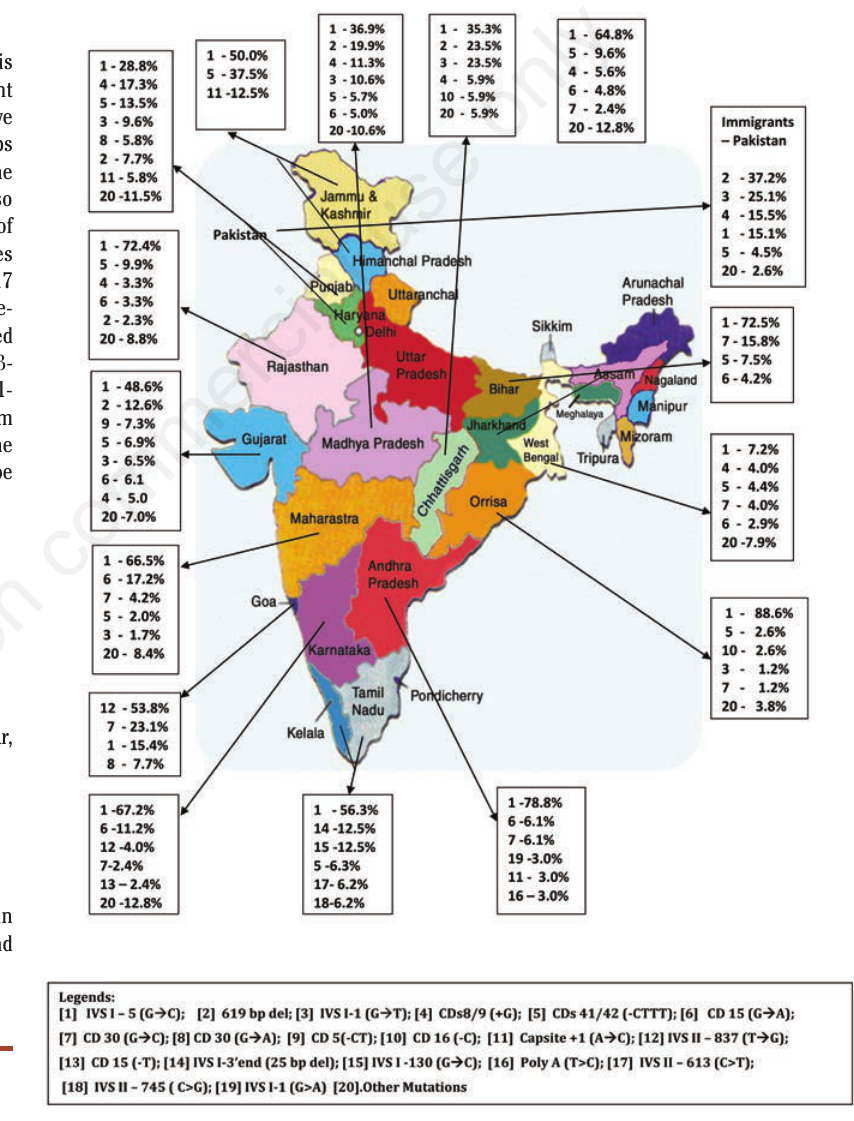
Figure 1. Map showing the distribution of the most common mutations in different